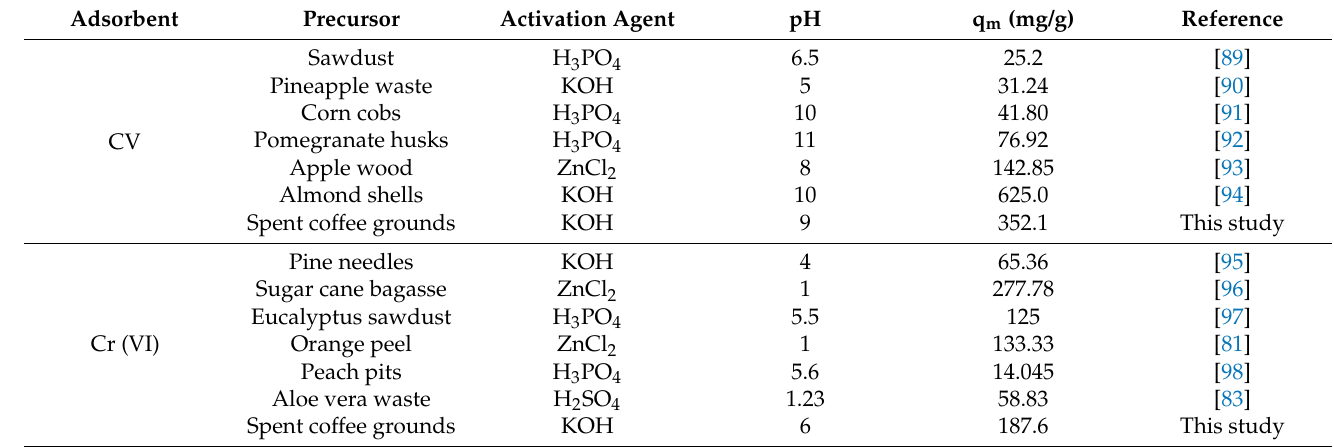
Table 8. Comparison of ACSCGs’s adsorption capacity with other activated